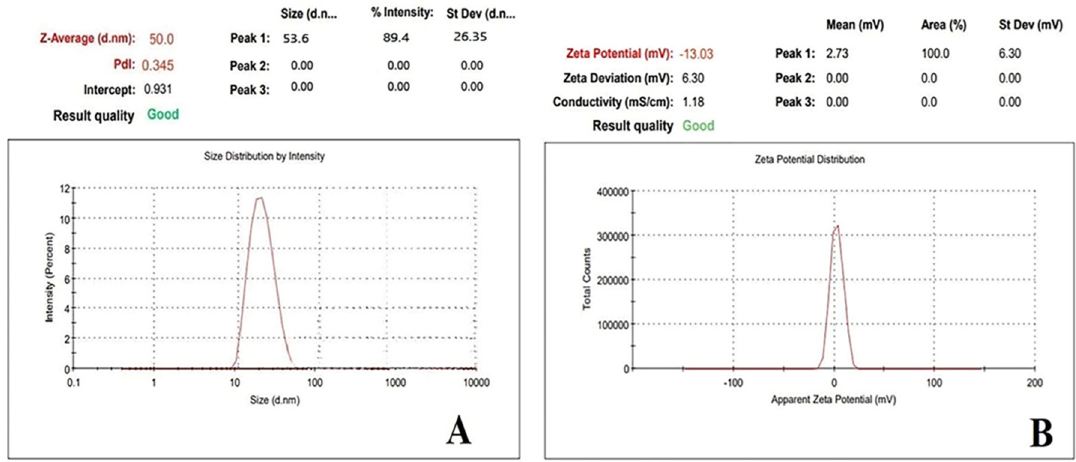
Figure 5. Depicts particle size ( A ) and zeta potential ( B ) for cytarabine ‐ loaded TINPs (CY ‐ TINPs).